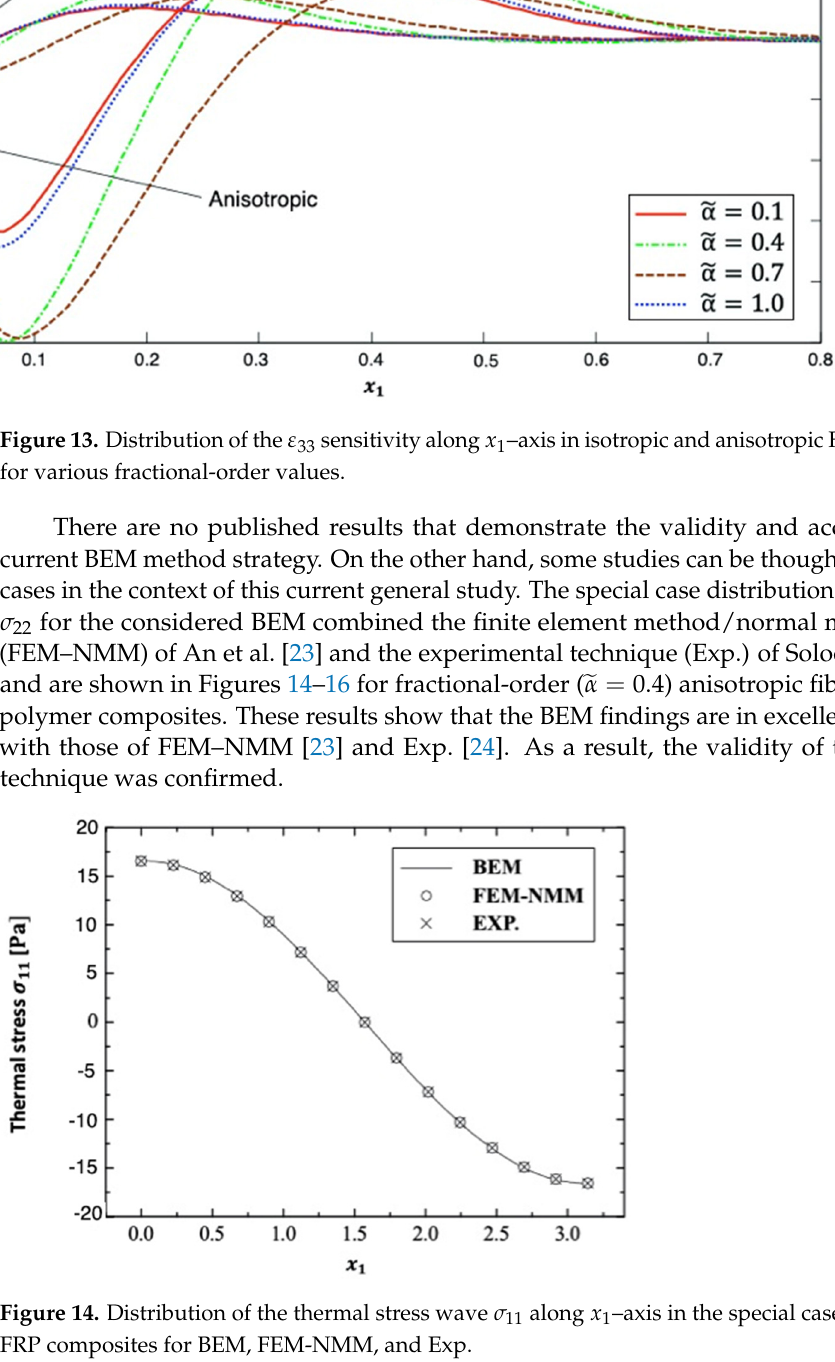
Figure 15. Distribution of the thermal stress wave 𝜎 (cid:2869)(cid:2870) along 𝑥 (cid:2869) – axis in the special case of aniso- tropic FRP composites for BEM, FEM-NMM, and Exp.